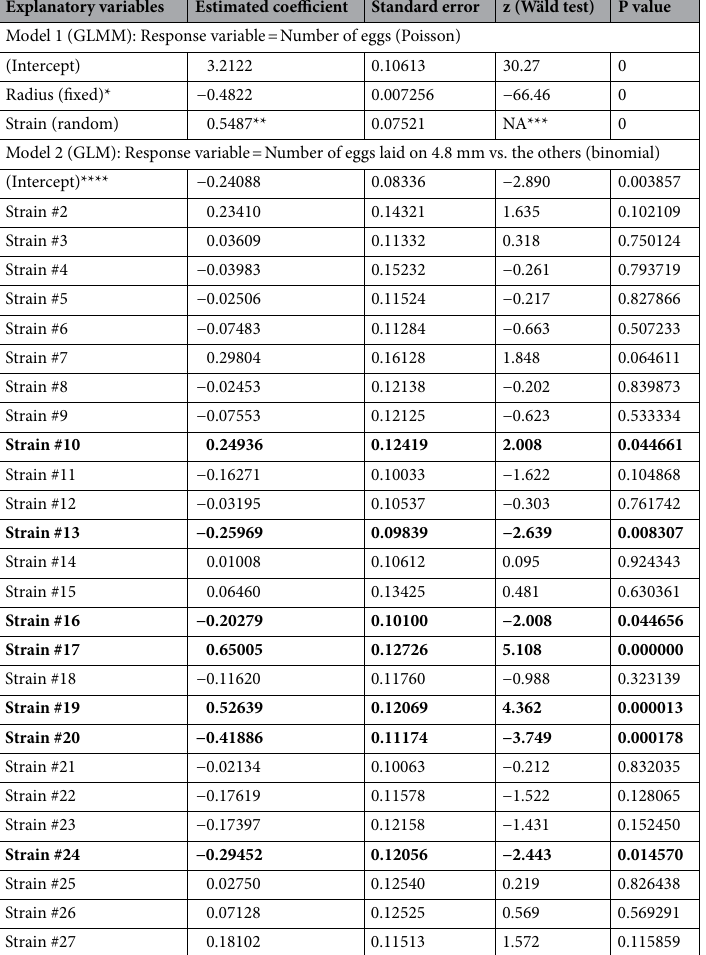
Table 2. Analysis of the result of four-choice assay. Significant values are in bold. * Values for the radius was transformed as {4.8 mm: 0; 5.7 mm; 1, 7.7 mm: 2; 9.6 mm: 3} (continuous). **For the random effect, estimated standard deviation is shown. ***For the random effect, P value was calculated using the bootstrap test. ****Strain #1 was assigned as a base strain (Intercept represents the preference of strain